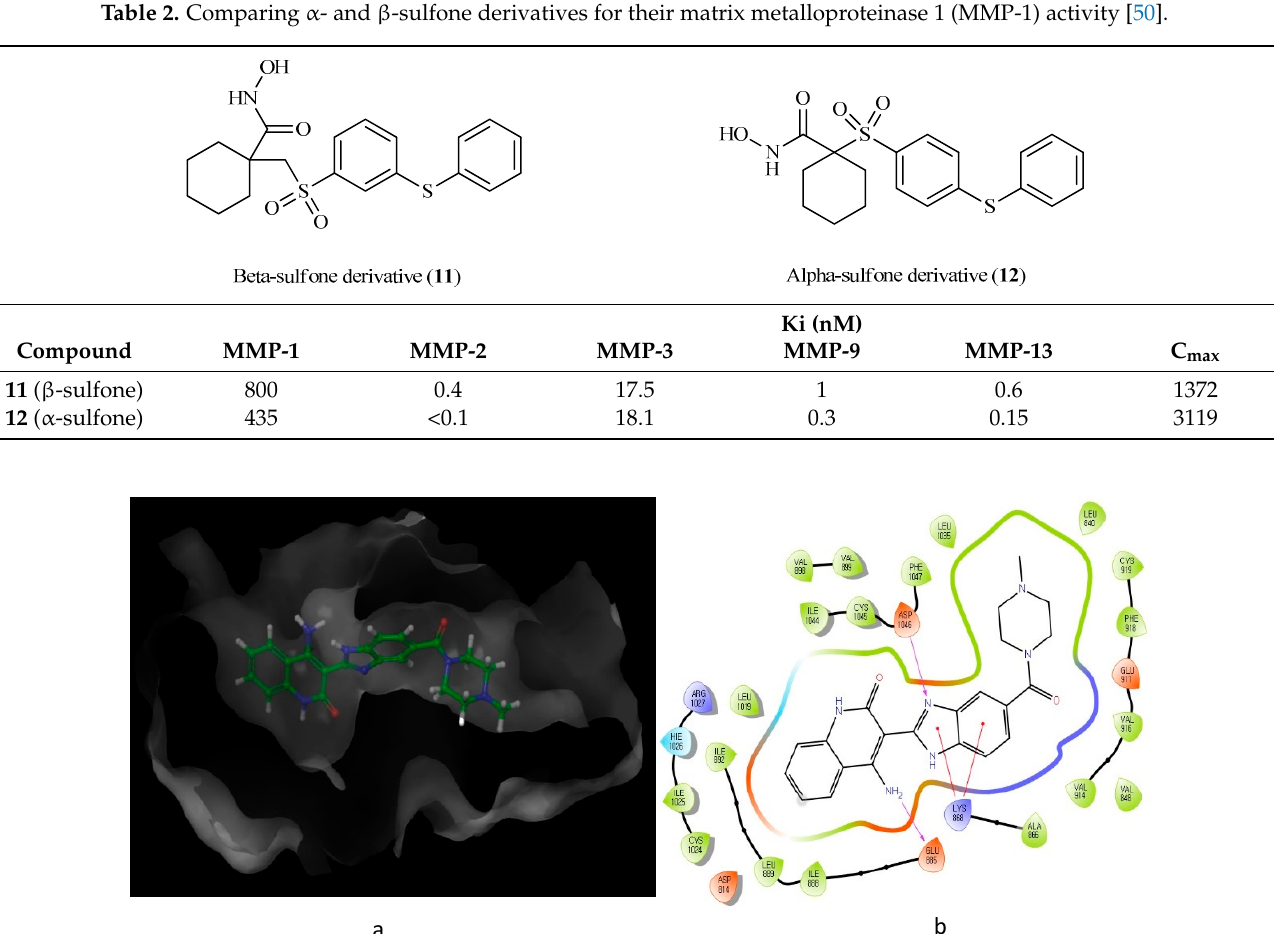
Molecules 2021 , 26 , 553